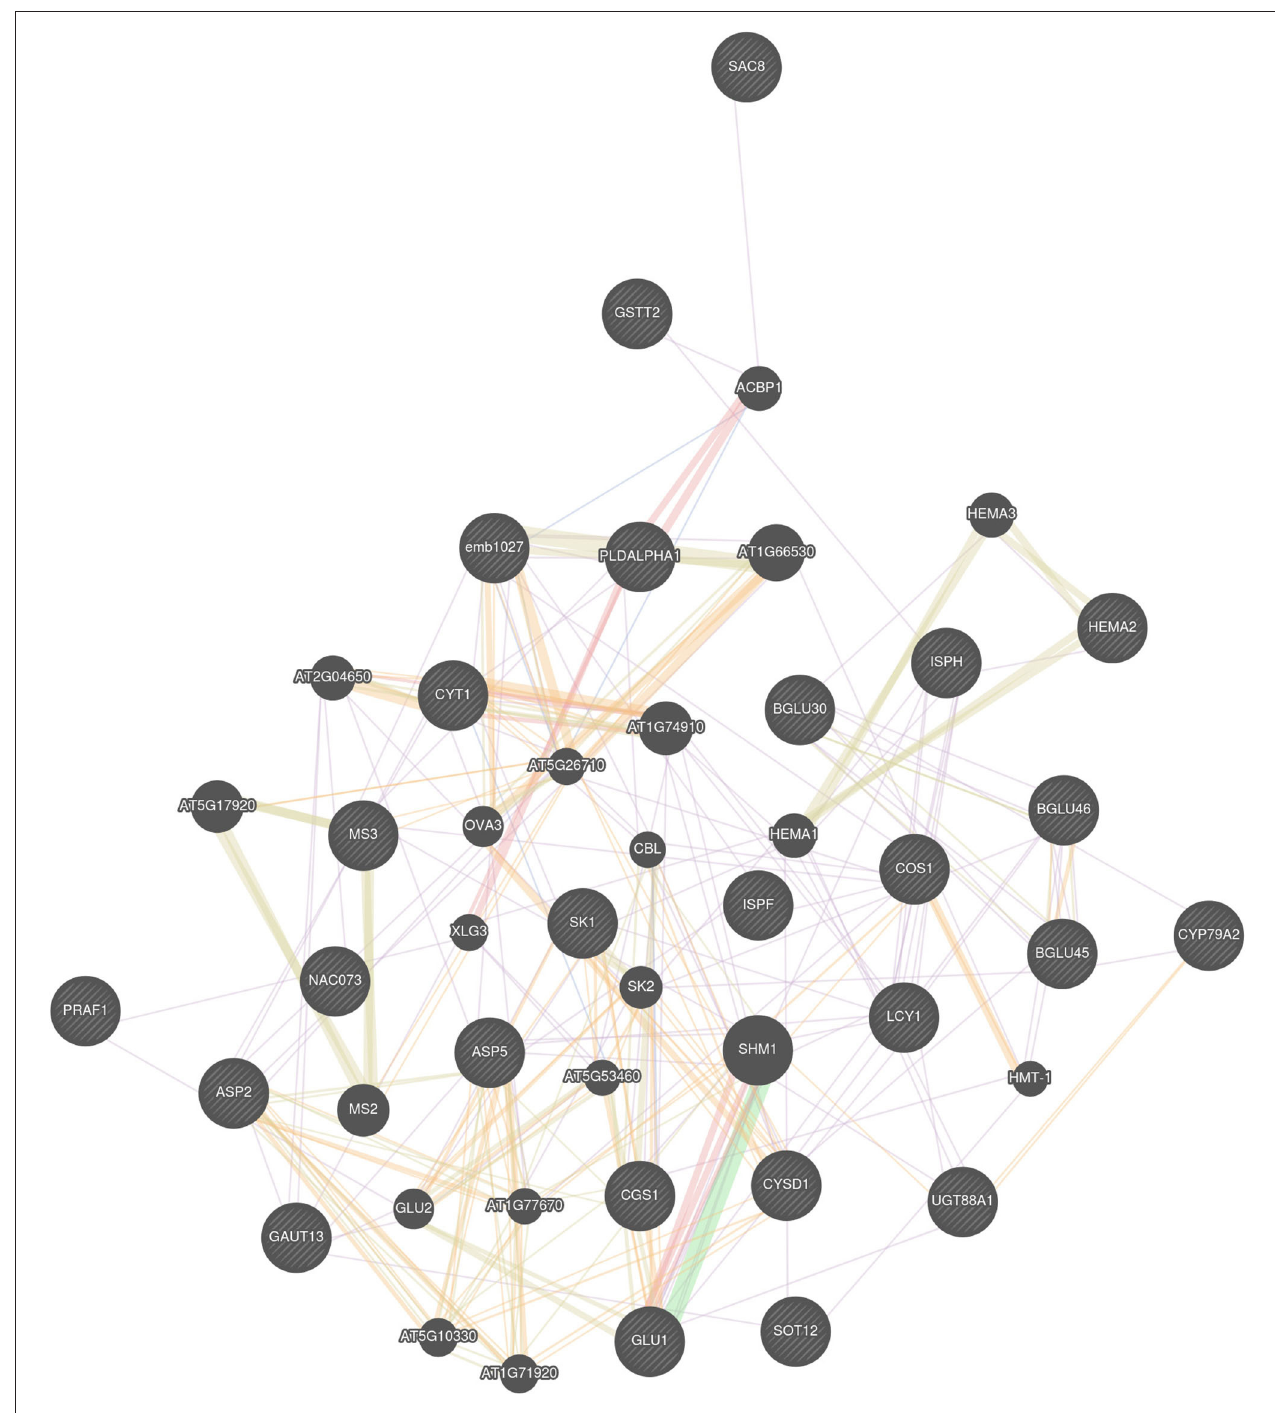
FIGURE 3 | Gene pathways detected by